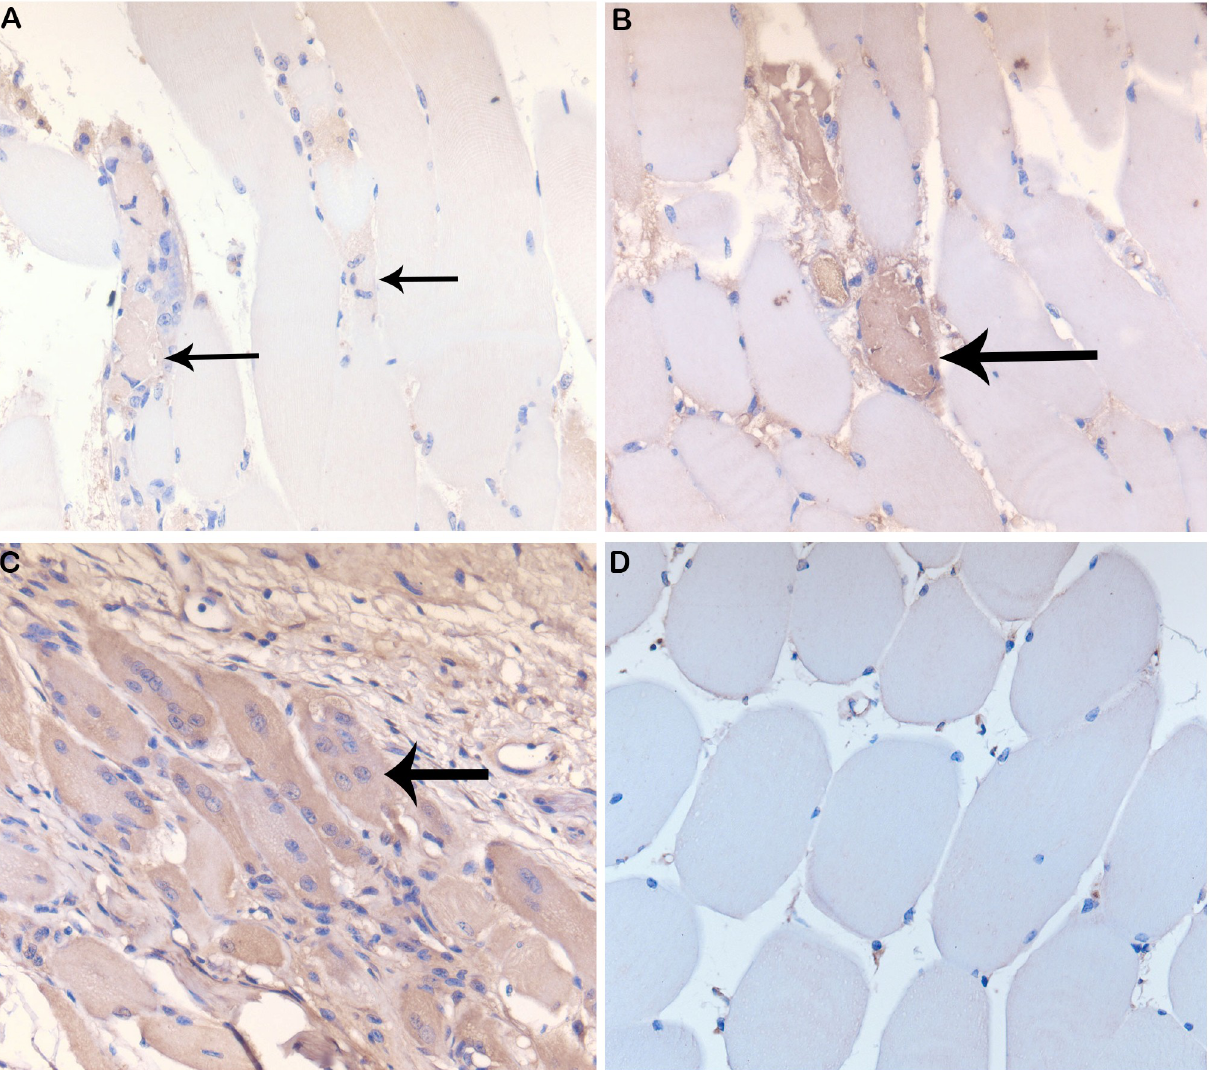
Fig 5. IHC of lesions in CHIKV-infected Hu-NSG mouse muscles. Immunohistochemistry (IHC) staining of CHIKV-infected mouse gastrocnemius muscle with CHK-263 antibodies. Positive staining (brown) represents CHIKV Env protein. ( A ) Control mouse with background IHC staining, 40X magnification. ( B ) Infected, degenerate muscle fibrils from minimal (score 1) myositis at day 7 post mosquito bite, 40X magnification. ( C ) Infected, degenerate muscle fibrils from mild (score 2) myositis at day 14 post mosquito bite, 40X magnification. ( D ). Infected muscle fibrils from moderate (score 3) myositis at day 21, 40X